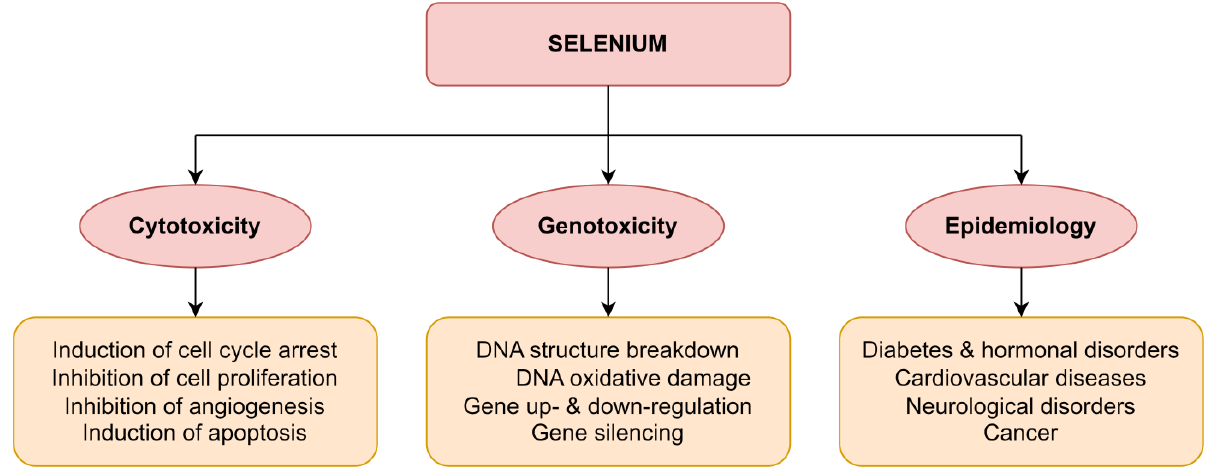
Figure 2. Selenium toxicity in humans and animals: cytotoxicity, genotoxicity, and epidemiology. To date, the anticancer activity of selenium is not yet fully demonstrated, especially its in vivo therapeutic efficacy. The main challenge lies in delivering specific concentrations of redox-active selenium directly to the target site (tumor or metastatic cells) to bring about the cytotoxic effect [89]. In the quest of innovative systems to upgrade the bioavailability and the controlled release of selenium, much attention has been focused on SeNPs, which have appeared as the answer to the toxicological concerns due to their novel properties, including high specific surface area, high degree of absorption, and low toxicity when compared to their inorganic and organic analogs [46,58]. As the alternative to elemental zero-valent selenium (Se 0 ), nanoscale selenium offers the advantage of a significantly low toxicity without affecting its ability to upregulate selenoenzymes at nutritional levels and induce phase II enzymes at supra-nutritional levels [90]. Nanoscale selenium is bright red, highly stable, and soluble; it has been processed for pharmaceutical and medical applications due to its anticancer, antimicrobial, antioxidant, and antidiabetic activity [62,91]. When released from the NP surface, the unstable Se 0 atoms are readily oxidized to inactive forms. To prevent this instability, proteins and polysaccharides are mainly used as nanocarriers; these include chitosan [51,92], egg white lysozyme [93], β -lactoglobulin [94], acacia gum, and carboxymethyl cellulose [95]. SeNPs have been integrated in simultaneous treatments involving immunotherapy,